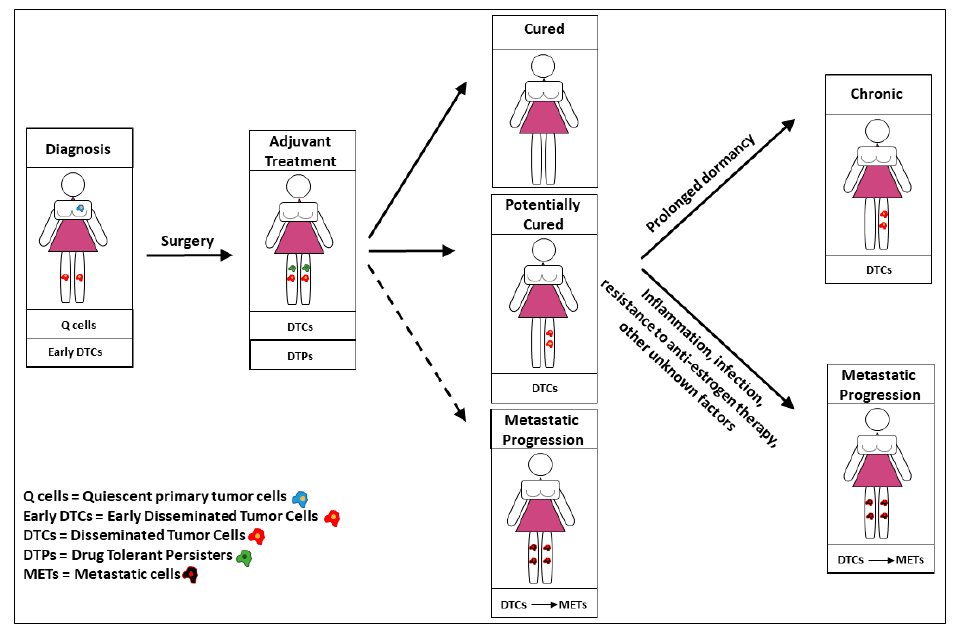
Figure 1. Role of quiescent / dormant breast cancer stem cells in patient outcome. Quiescent breast cancer stem cells are present in primary tumors particularly in hypoxic areas and can disseminate early during tumor progression. Chemotherapy may induce the formation of drug-tolerant persisters (DTPs) which survive treatment as well as dormant disseminated tumor cells (DTCs). Patient outcome is crucially determined by the fate of DTCs: patients are totally cured if dormant cells are eradicated by therapies, or potentially cured if DTCs remain alive and dormant. In potentially cured patients, DTCs can remain dormant throughout lifetime (resulting in a chronic but harmless presence of cancer) or awaken following inflammations, infections, emergence of endocrine therapy resistance, and generate metastatic tumours.